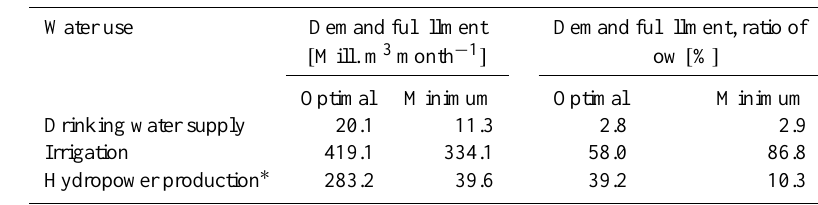
Table 5. Assumed average demand fulfillment for the various sectors in the SRPS. Optimal and minimum refer to level of demand fulfillment. Source: Sauterleute et al. (2012).